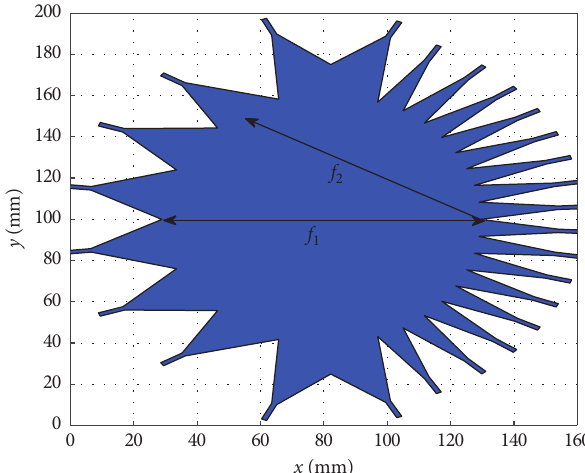
Figure 3: S-band Rotman lens port positions and position tolerances after IA refinement.